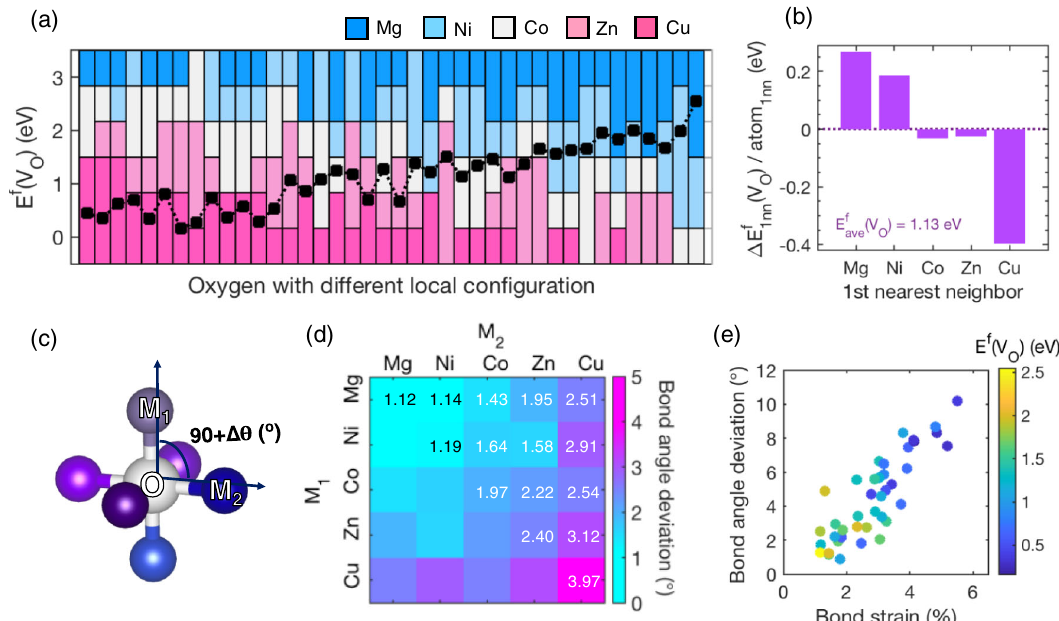
Fig. 2 Dependence of the oxygen-vacancy formation energy on the local con fi guration and structural distortion in (Mg 0.2 Ni 0.2 Co 0.2 - Cu 0.2 Zn 0.2 )O. a DFT-calculated formation energy of oxygen vacancy (V O ) as a function of fi rst-nearest-neighbor (1NN) shell composition. Each column represents a different oxygen atom in the cell and the cation combination for each 1NN shell is illustrated by the colored bars in the background. The data is ordered along the horizontal axis according to E f from our linear regression analysis. b The contribution of each 1NN cation to the oxygen vacancy formation, obtained by fi tting the DFT-calculated V O formation energies to the number of each 1NN cation with the linear-regression scheme. The formation energy of V O strongly depends on the local atomic con fi guration: it increases with an increasing number of Mg and Ni 1NN cations, and it decreases with more Cu 1NN cations. c Schematic of the octahedral arrangement of O in ESO, where the six 1NN cation sites are determined by the combination of the fi ve cation species. Different combinations of cations lead to different local bond-angle deviations, Δ θ (°) d The values of the average M 1 -O-M 2 bond-angle deviation from 90°, where M 1 and M 2 indicate metal cations in the ESO. Cu (Mg) contributes the most (least) to the distortion of bond angle. e The formation energy of V O as a function of average bond- angle deviation and average bond strain. The local structural distortion, determined by local bond strain and bond-angle deviation, decreases the formation energy of V O ’ s and increases their formation